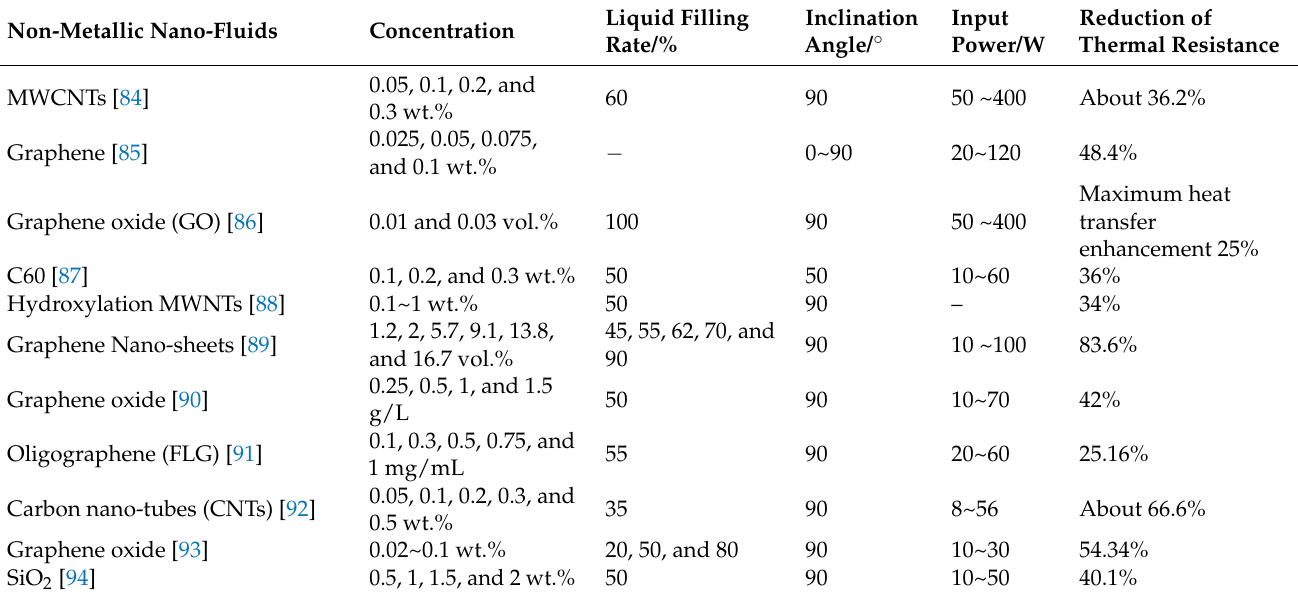
Table 2. Thermal properties of non-metallic